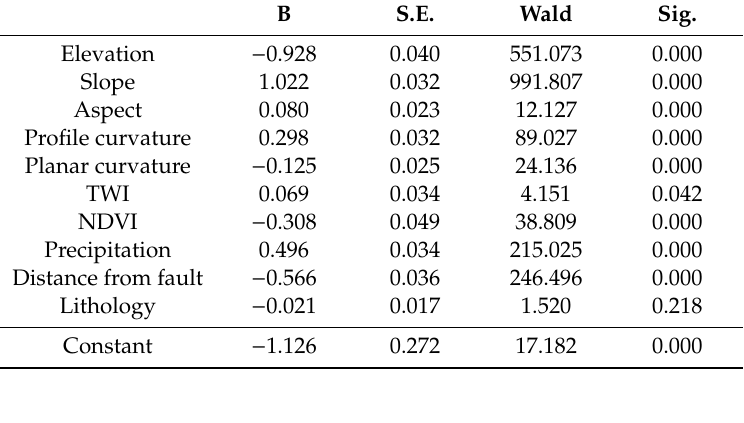
Table 3. Results of logistic regression analysis.